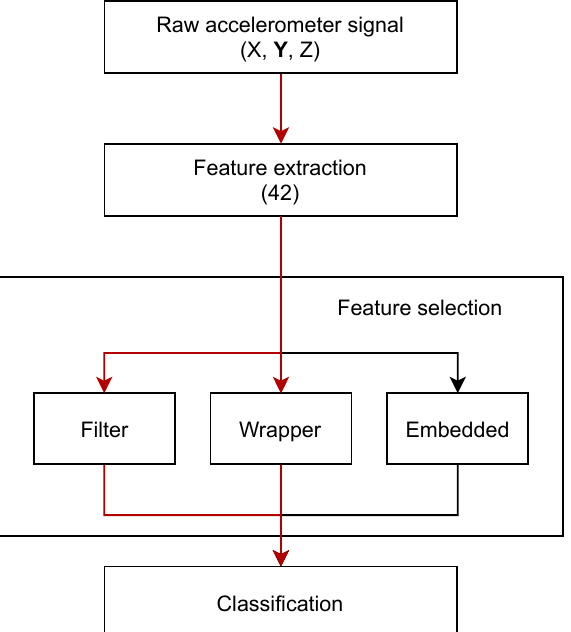
Figure 2. A block diagram showing the methodology starting from the raw data to training and evaluation of the classification algorithms. The red arrows indicate the adopted methodology followed in this